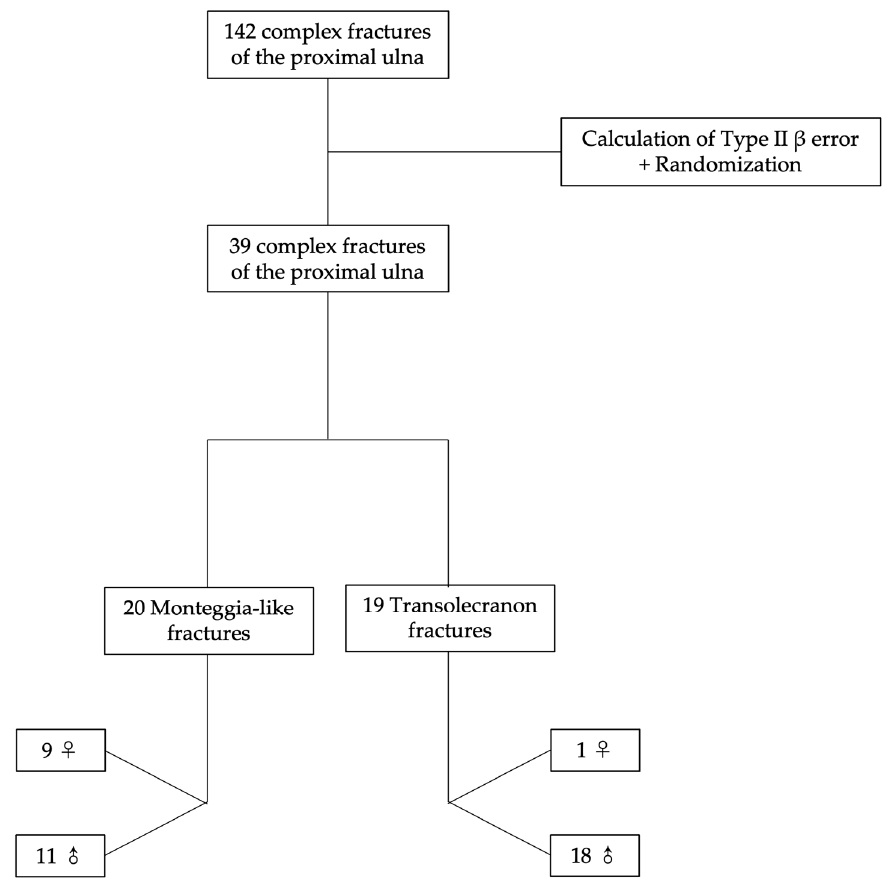
Healthcare 2023 , 11 , x FOR PEER REVIEW Figure 1. Selection process used for defining the images. Figure 1. Selection process used for defining the images.